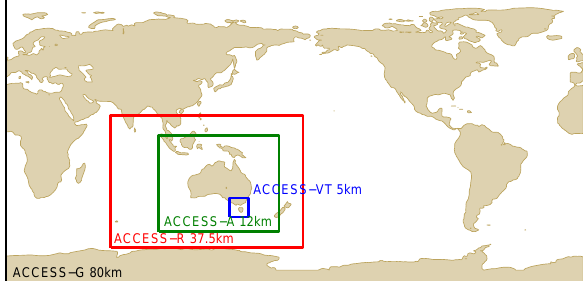
Fig. 1. Domains of initial ACCESS (APS0) NWP models used in this